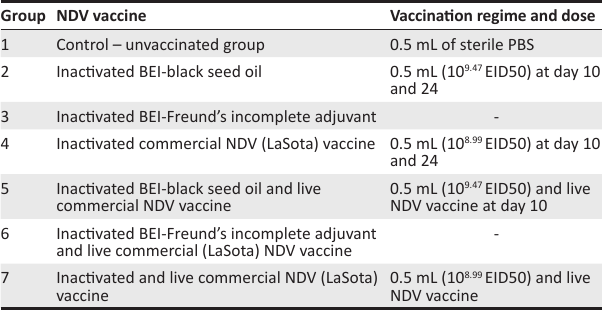
TABLE 1: Vaccination of specific pathogen-free chickens with different Newcastle disease virus vaccines. Group NDV